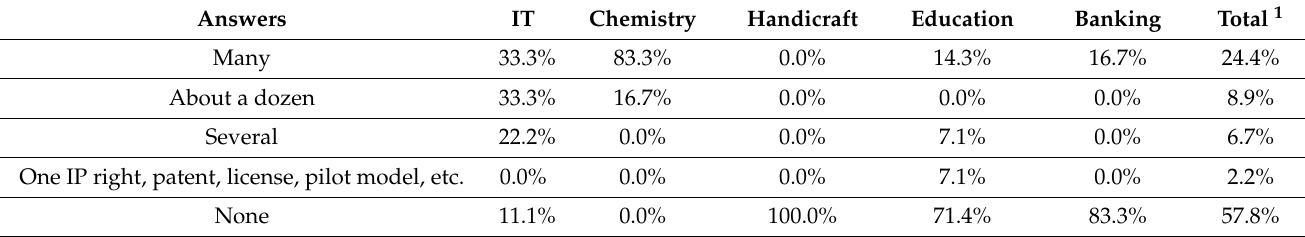
Table 4. Distribution of the number of intellectual property (IP) rights (patents, licenses, registered software, etc.). Answers IT Chemistry Handicraft Education Banking Total 1 Many 33.3% 83.3% 0.0% 14.3% 16.7% 24.4% About a dozen 33.3% 16.7% 0.0% 0.0% 0.0% 8.9% Several 22.2% 0.0% 0.0% 7.1% 0.0% 6.7% One IP right, patent, license, pilot model, etc. 0.0%